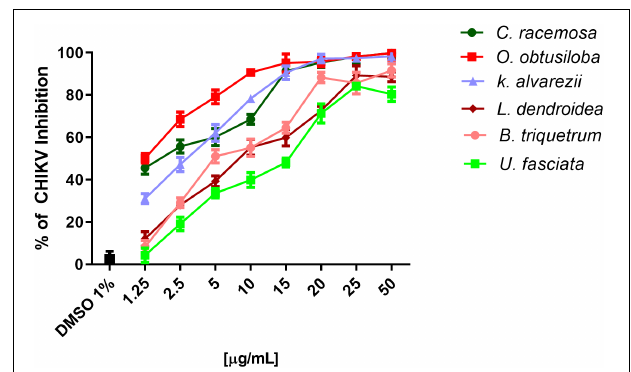
FIGURE 3 | Effect of six seaweeds crude extracts on CHIKV replication. Vero cells were infected with CHIKV (10 6 PFU/mL) at MOI of 0.1 and treated with different concentrations of the extracts, namely, 1.25, 2.5, 5, 10, 15, 20, 25, and 50 µ M. The results were evaluated by plaque assay. Error bars indicate the standard deviation and experiments were performed in triplicate. DMSO used as solvent remained at the final concentration of 0.01% showing no activity on CHIKV replication.